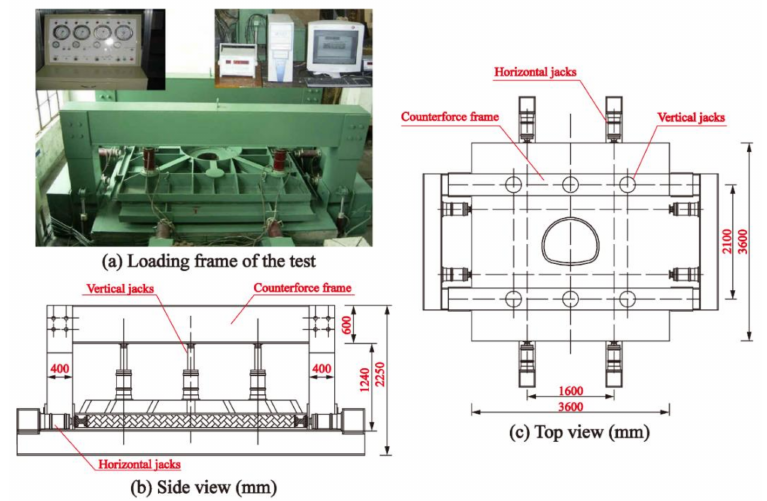
Figure 6. Soil-pressure loading test